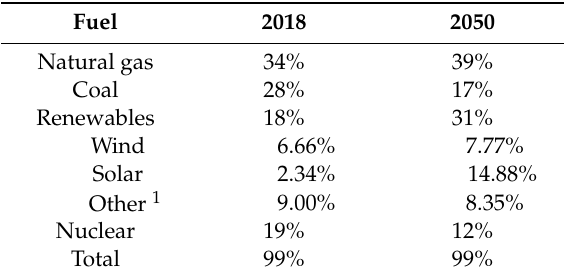
Table 1. Electricity generation from selected fuels [1].